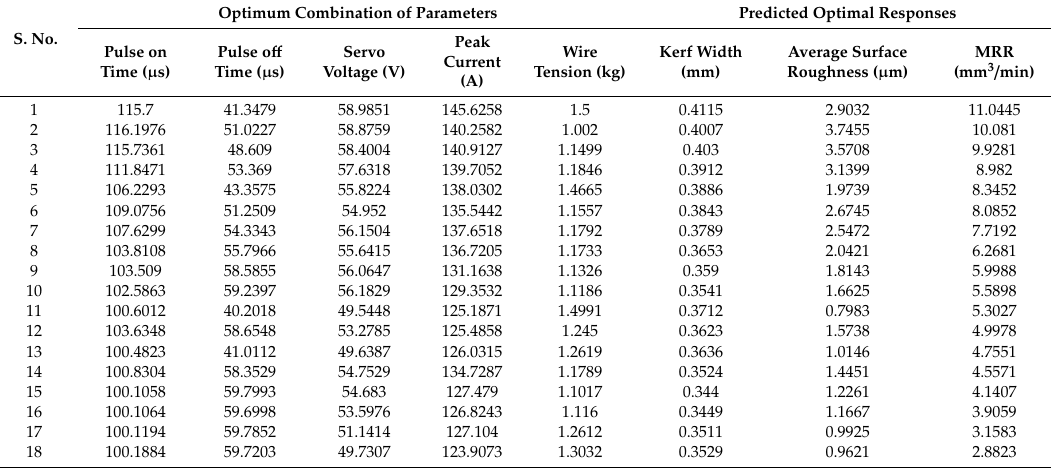
Figure 10. Pareto front of non-dominated solutions. Table 10. Optimal combinations of WEDM parameters and non-dominated solutions.